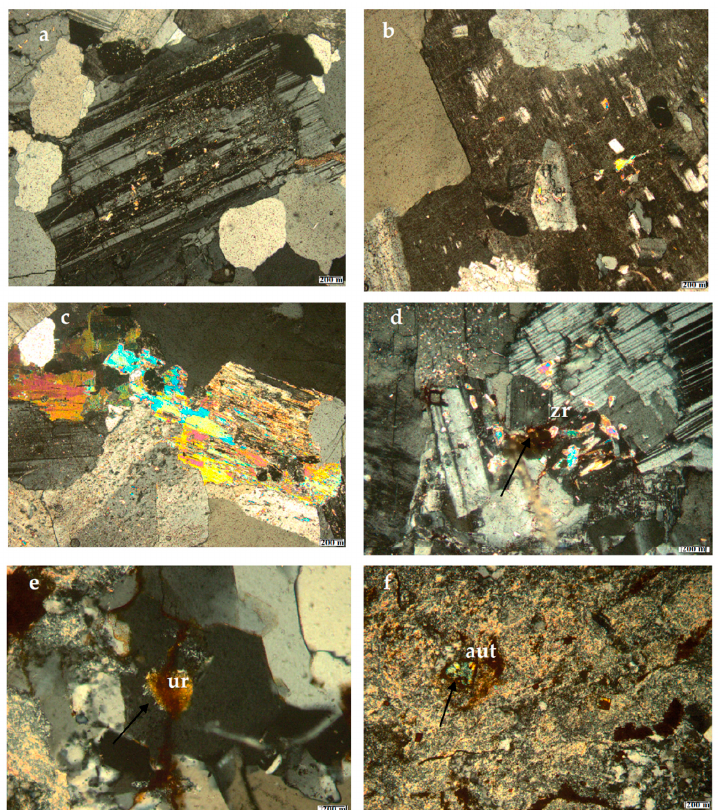
Figure 2. ( a ) Cracked crystal of plagioclase with partial saussiritization. ( b ) Euhedral crystal of antiperthite. ( c ) Flakes of biotite partially transformed to secondary muscovite, associated with plagioclase. ( d ) Well-formed crystals of zircon coated by iron oxides, associated with plagioclase. ( e ) Radioactive mineral that may be uranophane in quartz. ( f ) Well-formed crystals of autunite, associated with silicification.